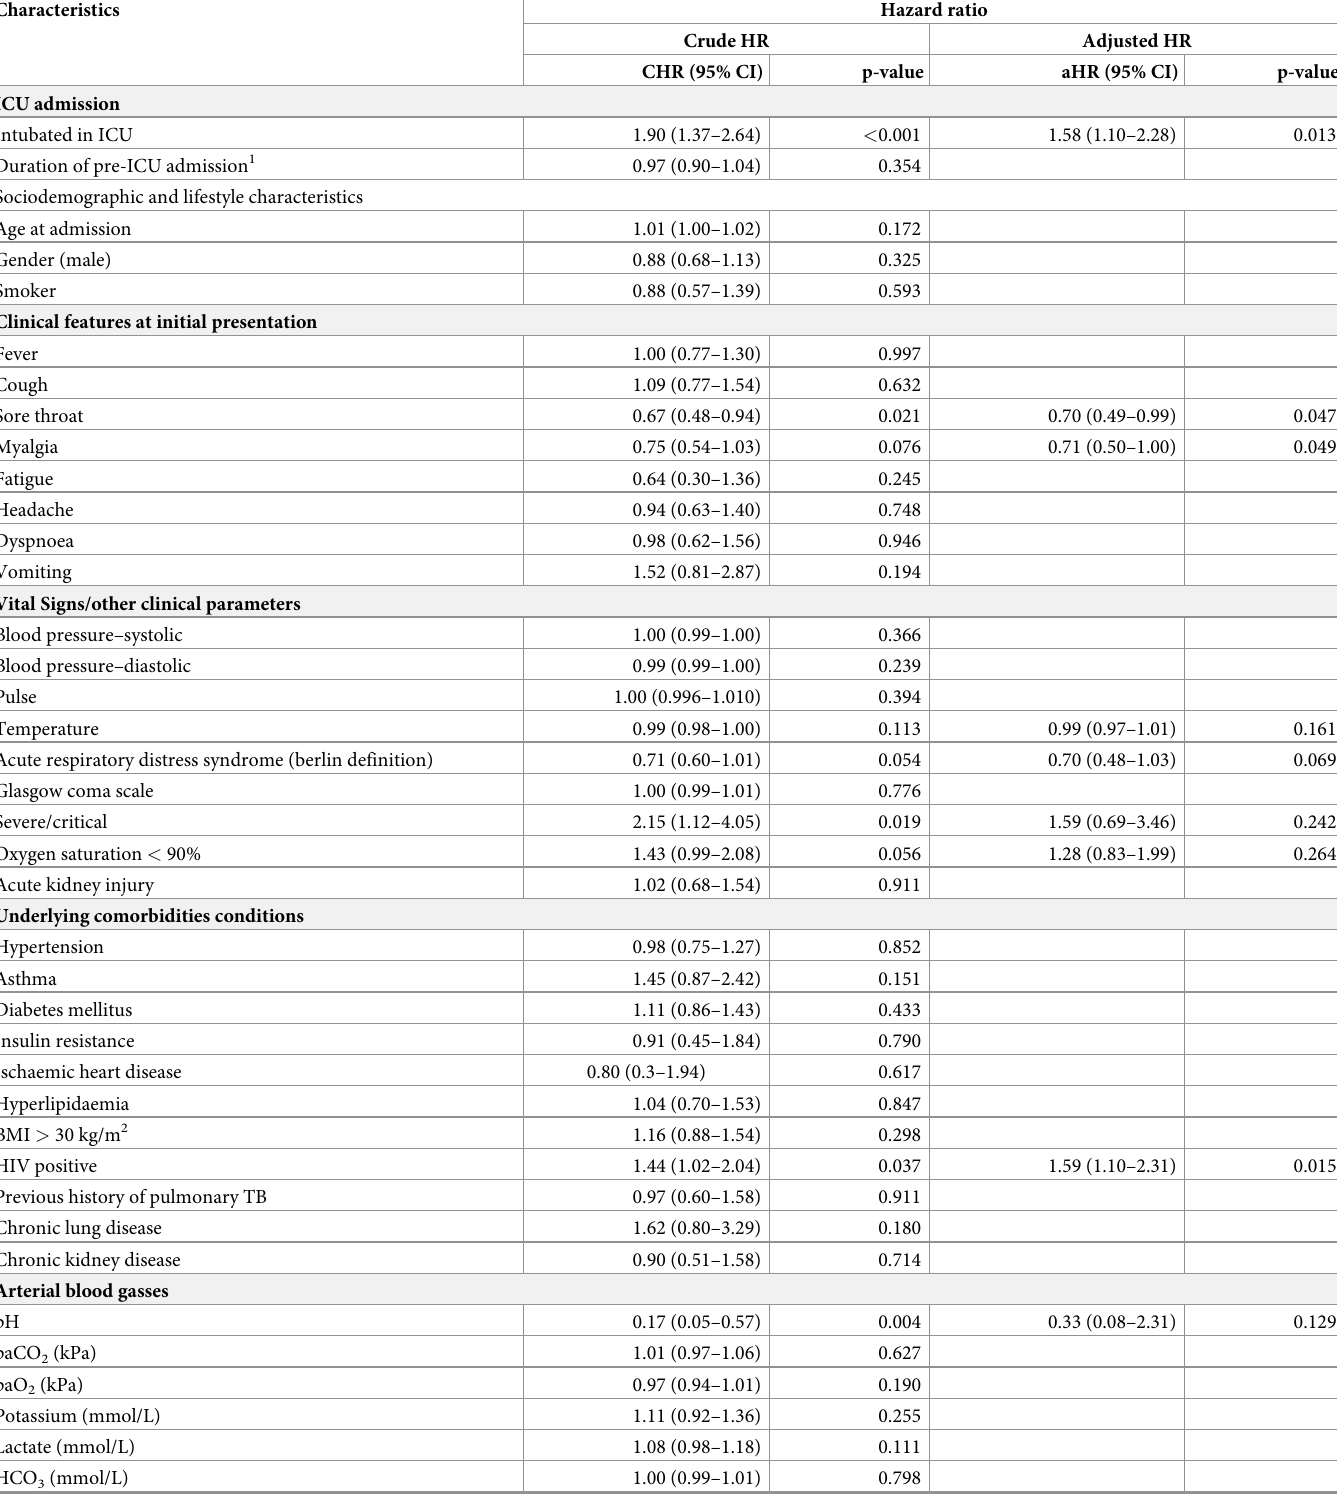
Table 4. Cox proportional hazards model identifying factors associated with the risk of hazard ratio among COVID-19 patients admitted to the ICU.